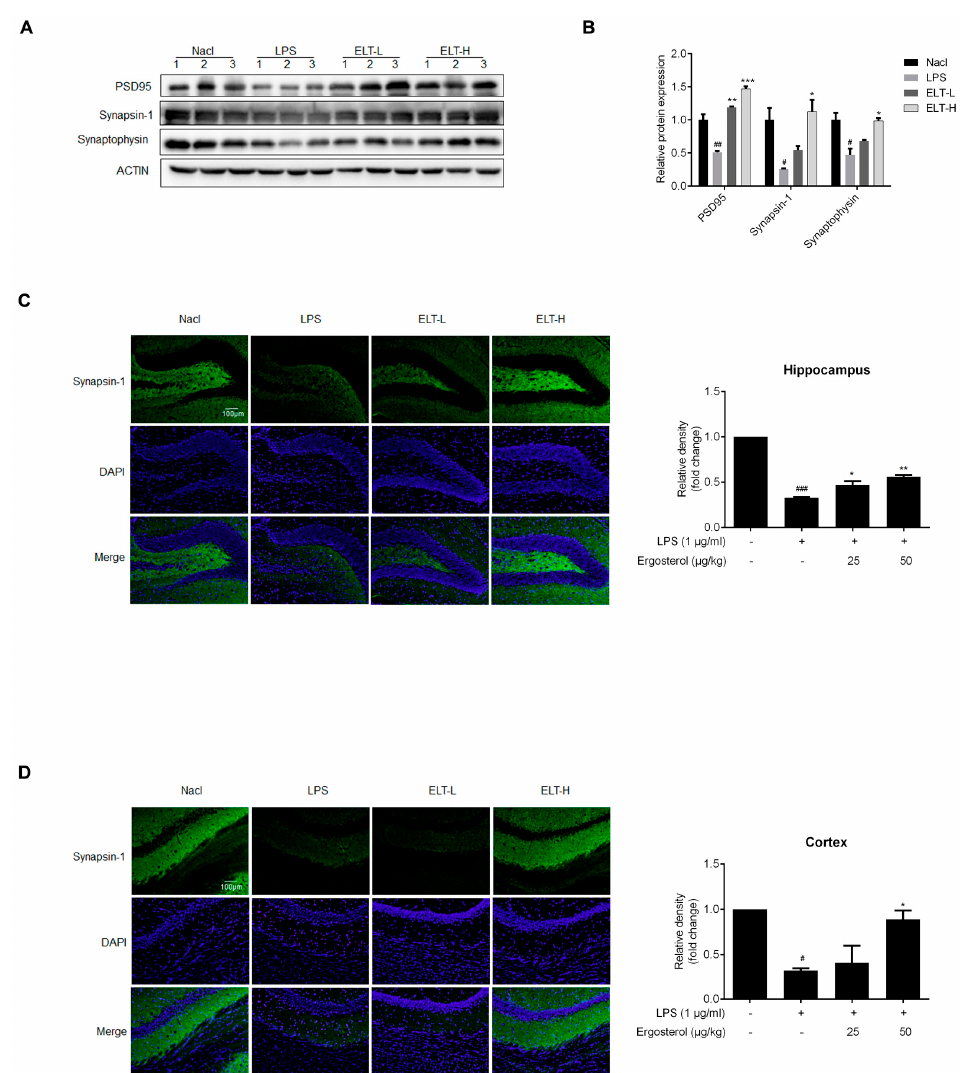
Figure 5. Ergosterol significantly reduced LPS-induced neuron injury in ICR mice. ( A ) The PSD95, Synapsin-1, and Synaptophysin protein levels in the cortex of mice were determined by Western blot. Actin was used as a housekeeping control (Nacl, n = 3 mice; LPS, n = 3 mice; ELT-L, n = 3 mice; ELT-H, n = 3 mice). ( B ) The densitometric method was used to estimate the relative expression of the protein compare with actin. ( C , D ) Immunohistochemistry was performed on anti-Synapsin-1 antibody. DAPI was used as a marker of the nucleus. Quantification of the relative fluorescence strength of Synapsin-1 in the region of the cortex or hippocampus was analyzed (Nacl, n = 8 mice; LPS, n = 8 mice; ELT-L, n = 8 mice; ELT-H, n = 8 mice). All data are mean ± SEM of triplicate values. Statistical significance was analyzed using one-way ANOVA and t test. # Significantly different from the control; * significantly different from the LPS-treated group. Significance: # p < 0.05, ## p < 0.01, ### p < 0.001, * p < 0.05, ** p < 0.01, *** p < 0.001.